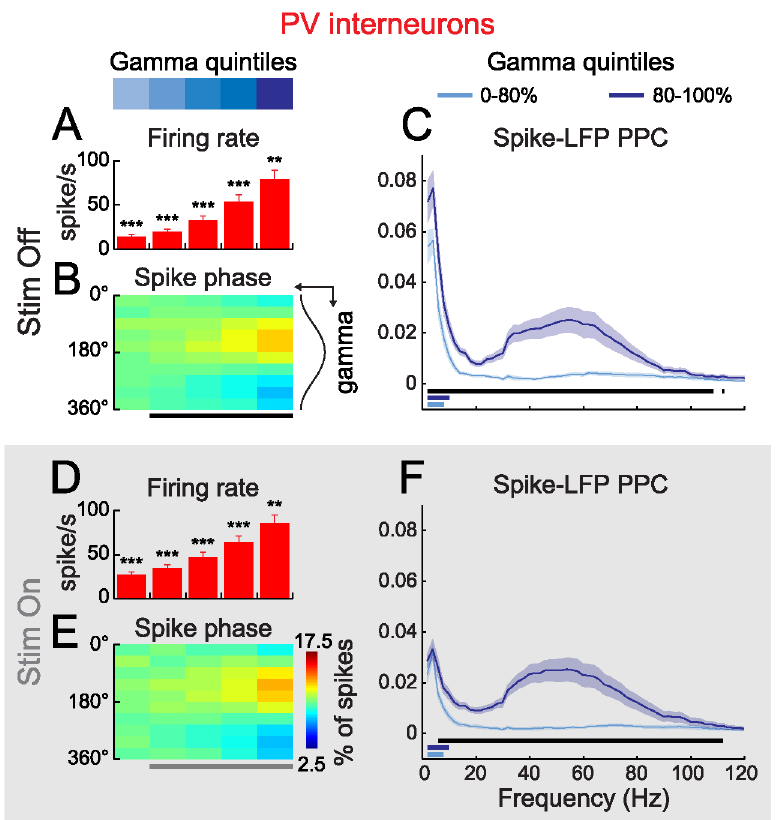
Fig 3. The firing of PVs phase locks to strong gamma oscillations. ( A, D ) Grand mean firing rate of PVs, outside (A, Stim Off) and during (D, Stim On) visual stimulation, as a function of gamma quintile at spike time ( n = 23; error bars: s.e.m.; ** : p < 0.01, *** : p < 0.001, signed rank test). ( B, E ) PV spikes occur preferentially before the trough of strong gamma outside (B) and during (E) visual stimulation (color-code in (E): fraction of spikes falling in one of ten bins of gamma phase as a function of gamma quintile at spike time; black and gray lines in (B) and (E): statistical difference from a uniform distribution, Rayleigh ’ s test, α = 10 − 5 ). ( C, F ) Strong gamma increases Spike-LFP Pairwise Phase Consistency (PPC) in the gamma range (30 – 80 Hz) outside (C) and during (F) visual stimulation ( n = 23; light and dark blue traces: grand mean PPC respectively in the four weakest quintiles and in the strongest gamma quintile; shaded areas: +/- s.e.m; horizontal lines: statistical significance between the four weakest quintiles and the strongest gamma quintile (black) and between Stim Off and Stim On for the four weakest quintiles (light blue) and the strongest gamma quintile (dark blue), FDR corrected signed-rank test, α =